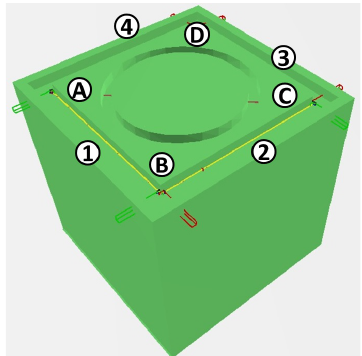
Figure 8. Workpiece model and task definition with corners A, B, C and D. Red and green vectors represent the x and y direction of the product frame as described in Section